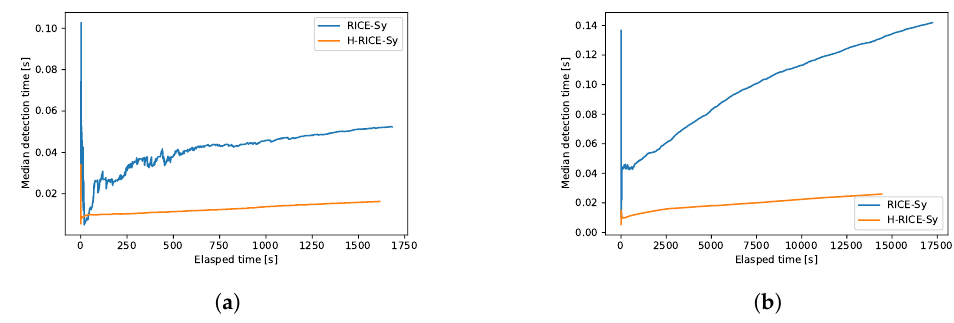
Figure 14. Comparison of the median detection time evolution between RICE-Sy and H-RICE- Sy on D 1 and D 3 . ( a ) Measurement where 30% of MKUs in D 1 are affected to malicious users. ( b ) Measurement where 30% of MKUs in D 3 are affected to malicious